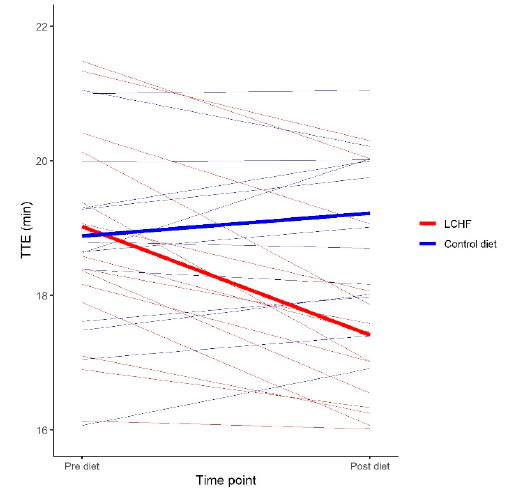
Figure 2. Individual changes of time to exhaustion (TTE) during a graded incremental ergometer cycling test. Pre-diet (day − 5 to − 2) and Post-diet (day 25–27) of the feeding trials. The ketogenic low-carbohydrate high-fat diet (LCHF) is indicated with red lines, and the Control diet is indicated with blue lines. Thick lines represent mean values for respective diet. Shown are data when both Pre-diet and Post-diet data points are available ( n = 14 for both diets).